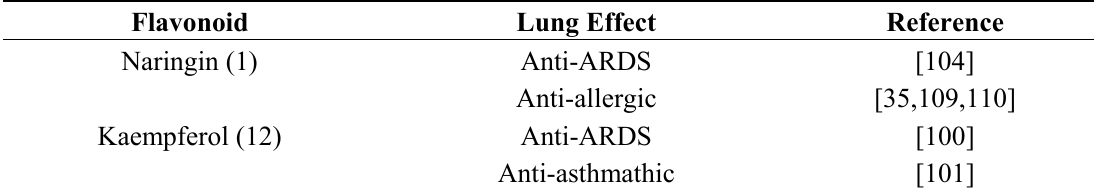
Table 1. Active flavonoids in lung inflammation and